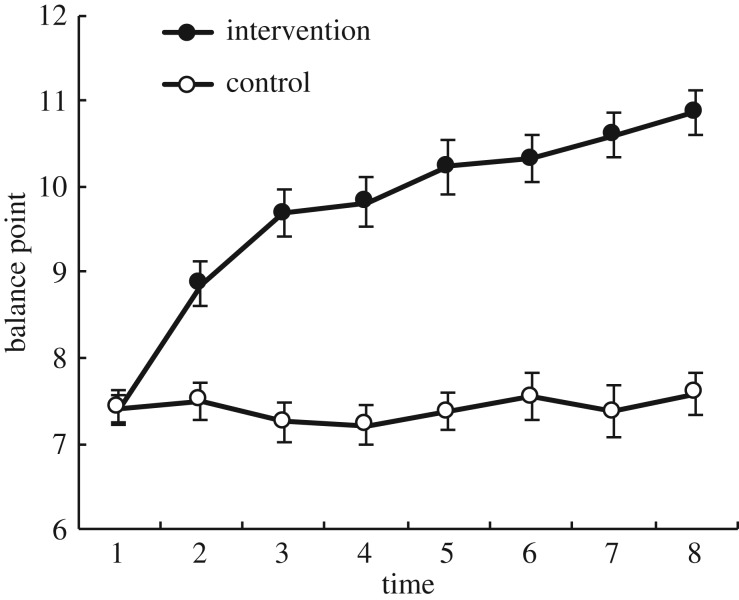
Mean baseline phase balance point for intervention and control participants across eight FIBM sessions. Error bars indicate standard error of the mean (s.e.m.).